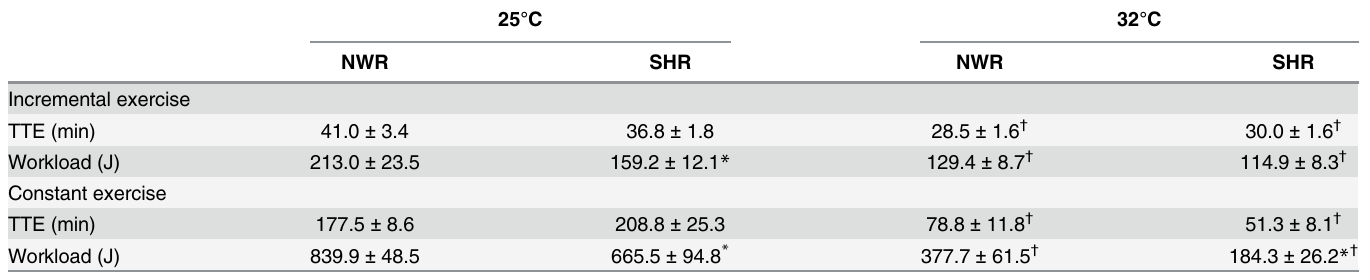
Table 4. Physical performance of the SHRs and NWRs during incremental or constant